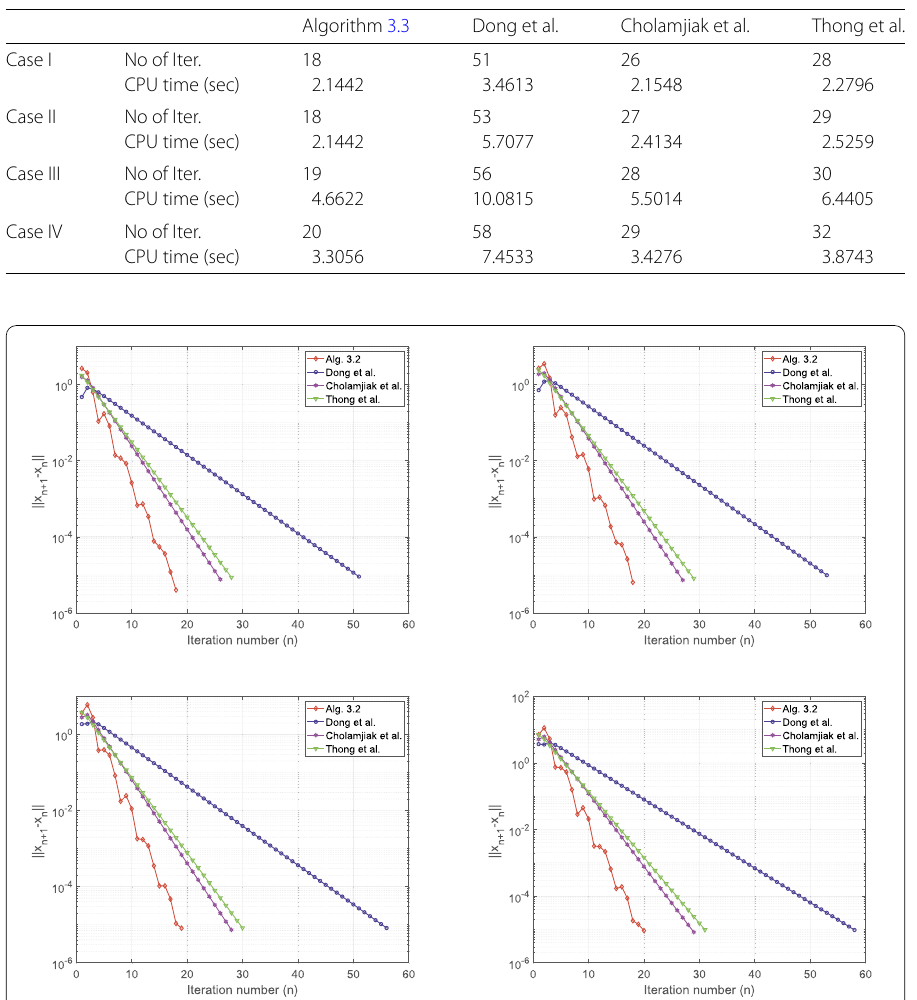
Figure 1 Example 4.1, Top Left: Case I; Top Right: Case II; Bottom Left: Case III; Bottom Right: Case